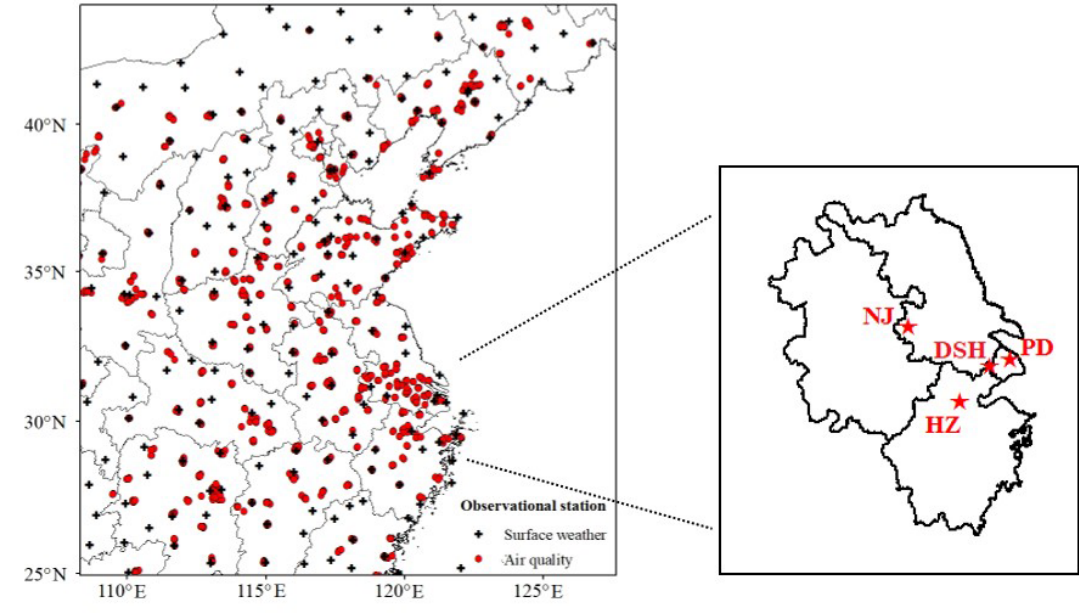
Figure 1. WRF-Chem domain configuration and observational stations. Black crosses: surface weather stations; red dots: CNEMC routine air quality monitoring stations; red stars: surface supersites in